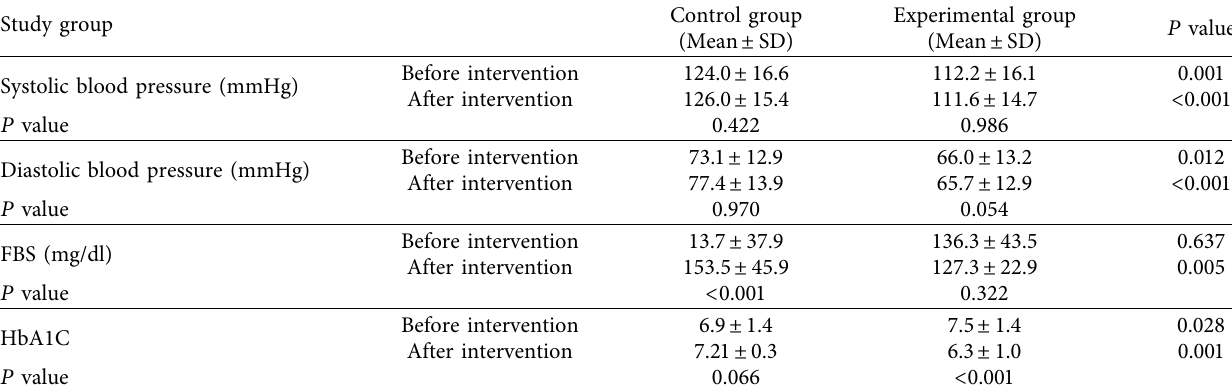
Table 2: Comparison of mean blood pressure, FBS, and HbA1C in patients before and after the